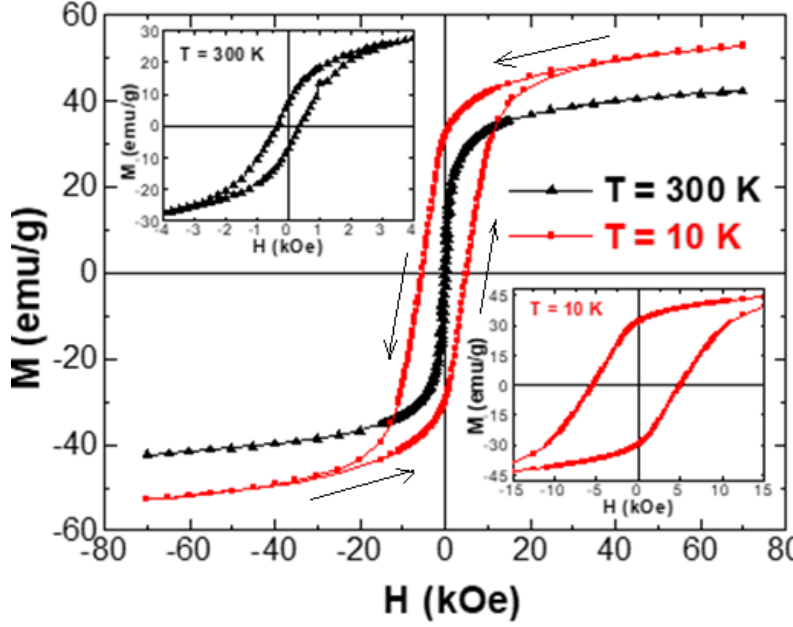
Figure 5. Magnetization versus applied magnetic field performed at T = 300 and 10 K for Co 0.5 Ni 0.5 Fe 2 O 4 NSFs. The insets show magnified views of the region near the origin (H = 0 kOe).